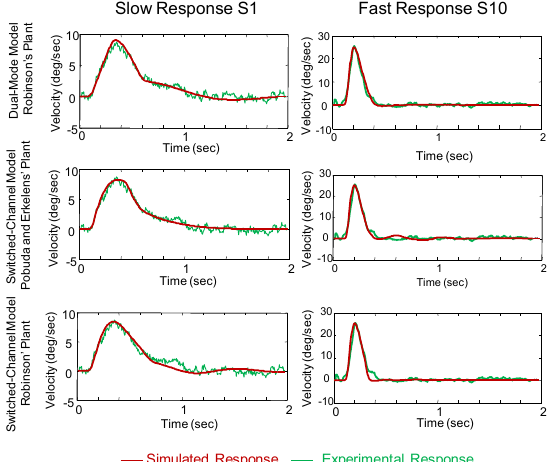
Figure 5: Comparison of slow and fast velocity responses us- ing dual-mode and switched-channel models following the format used in figure 4. Note, the velocity axes are different scales for the slow and fast responses from S1 and S10. Both models with either plant can model the experimental respons-